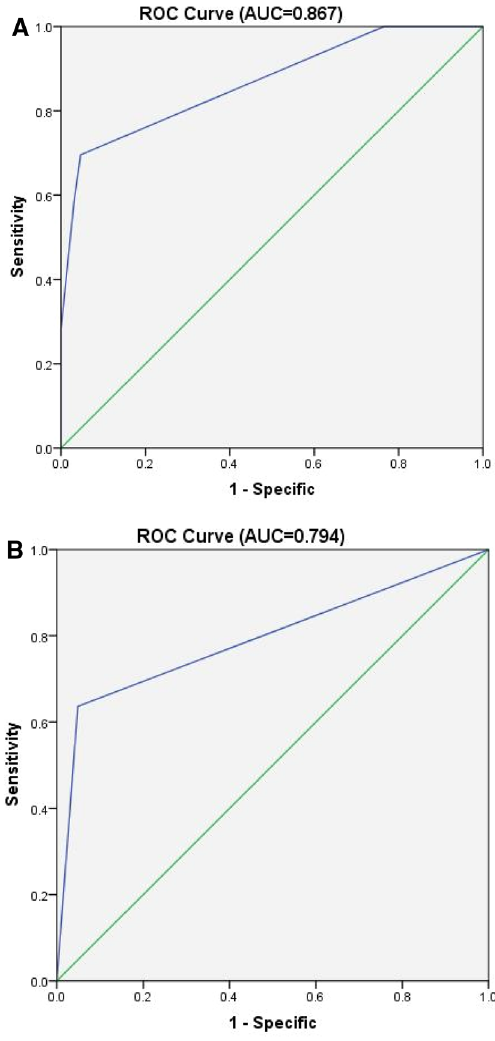
Figure 2. The ROC curve of the multivariate logistical regression model. The area under curve (AUC) was 0.867 and 0.794 for the group of thymic carcinoma ( A ) and high-risk thymoma ( B ), respectively.